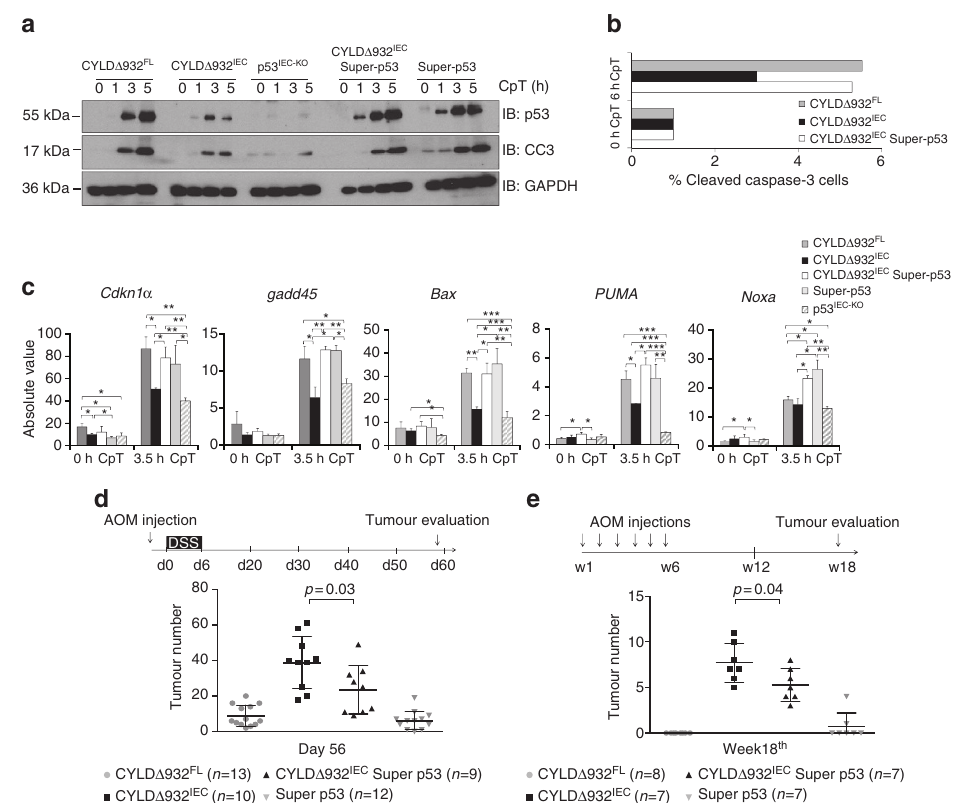
Figure 4 | p53 overexpression restores DNA damage-induced cell death and reduces tumorigenesis in CYLD D 932 IEC mice. Immunoblot analysis of p53, cleaved caspase-3 (CC3) and GAPDH ( a ), quantification of cleaved caspase-3-positive cells by FACS analysis ( b ) and qRT-PCR analysis of p53 target genes expression ( c ) in CpT-treated organoids from the indicated mice. Graphs in c show means of the absolute values ± s.d. of biological triplicates. Statistical significance was determined with Student’s t -test; * P r 0.05, ** P r 0.005, *** P r 0.0005. ( d ) Male littermate mice from the indicated mouse lines were injected with 7.5mgkg (cid:2) 1 AOM and 4 days later were given 2% DSS for 5 days. Graph shows colon tumour numbers on day 56. Pooled results from two different experiments are shown. ( e ) Female littermate mice from the indicated mice lines received weekly injections of 10mgkg (cid:2) 1 AOM for 6 weeks. Graph depicts colon tumour numbers on week 18. For the cancer experiment, data is shown as mean ± s.d. Statistical significance was determined with Student’s t -test; P values are shown. qRT-PCR, quantitative real-time